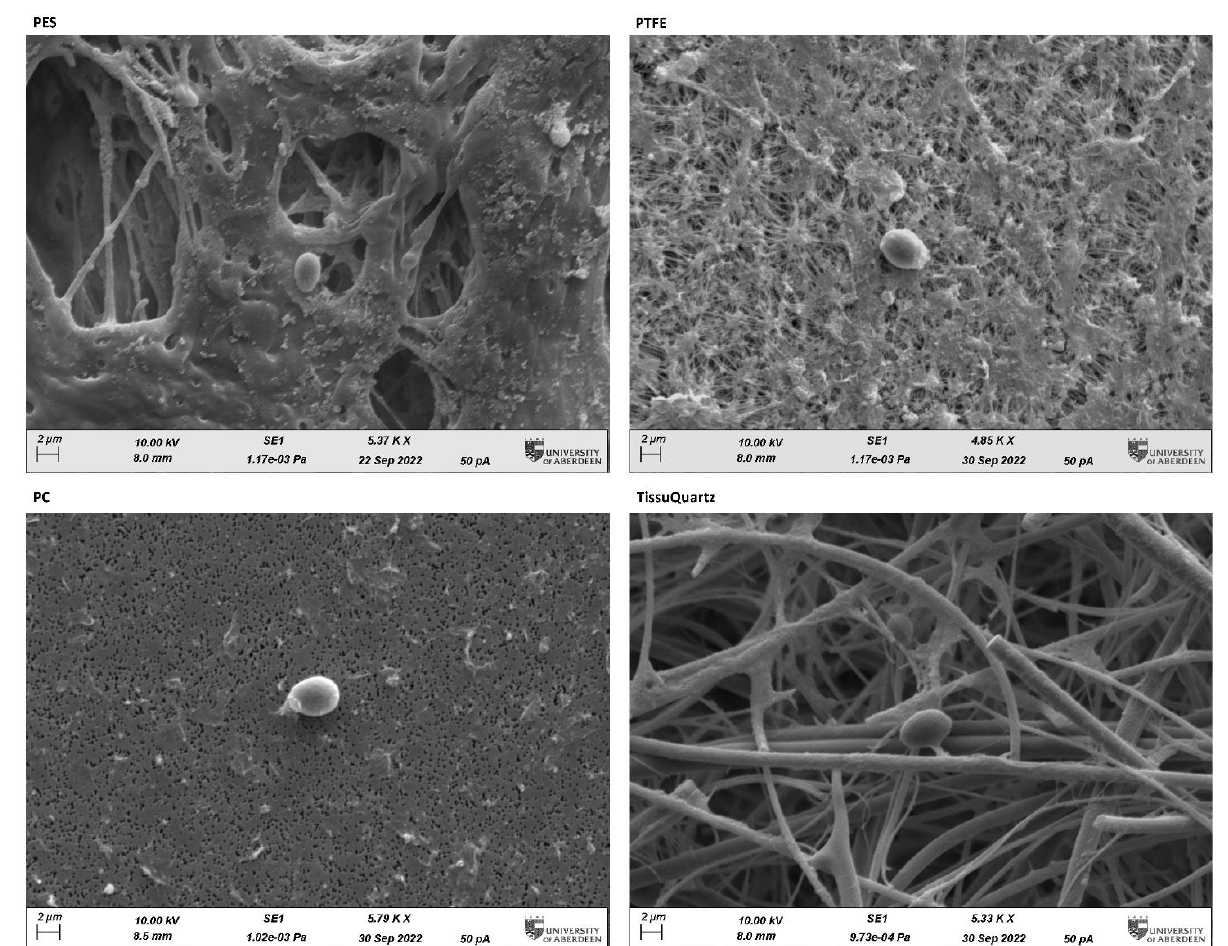
Figure 6. SEM images captured at ~5.00 K X Zoom using 10.00 KV electron beam on the post-sampled filters subjected to yeast bioaerosol generated within the constrained chamber. The oval-shaped single yeast cell can be distinctively seen captured onto the different filters. The microscale characterization of the filters using SEM imaging reveals the morphology and structure of the filters and their influence on trapping bioaerosol particles. PES (hydrophilic) and PTFE (hydrophobic) have good loading capacity due to higher surface area of entrapment. PC is a flat filter and has the least surface area for bioaerosol loading. TissueQuartz is a fibrous filter and has good loading capacity but suffers from lower efficiency compared to membrane filters.